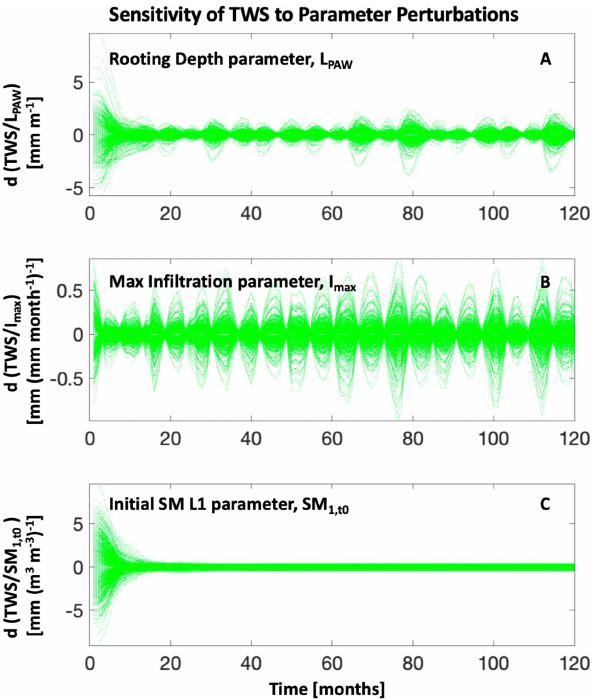
Figure 2. Sensitivity of the model-simulated TWS to minor per- turbations in parameter values. Shown here (from top to bottom) are sensitivities to (a) the rooting depth parameter, (b) the maxi- mum infiltration parameter, and (c) the soil moisture initialization parameter for layer 1. Green curves are the changes in simulated TWS (dTWS) when each parameter is perturbed (dPar) by 1% of its prior range, indicating the magnitude and the time steps of model sensitivity. TWS sensitivities to other parameters are shown in Fig. S3. The x -axis depicts the number of months since 2003, showing the 10-year period starting in January 2003 and ending in December